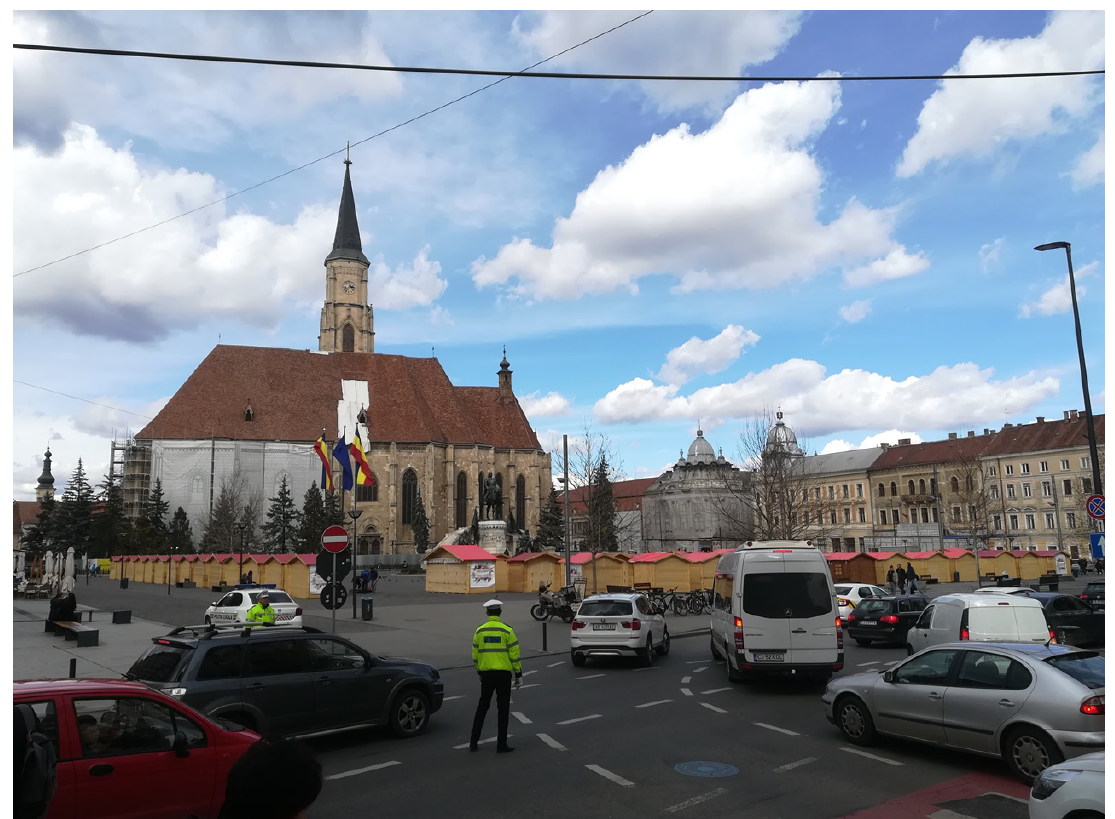
Figure 1 6 : March fair with specific urban furniture and retail units in the Union Square Source: Alexandru- Sabin NICULA,